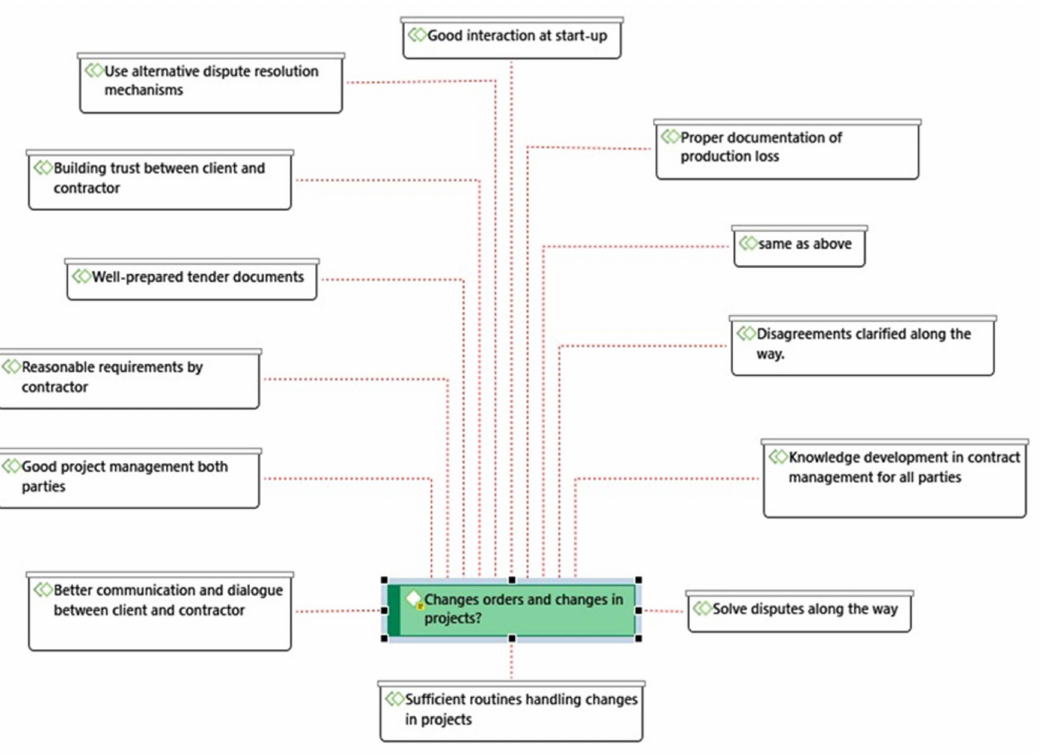
Figure 6. Thematic map